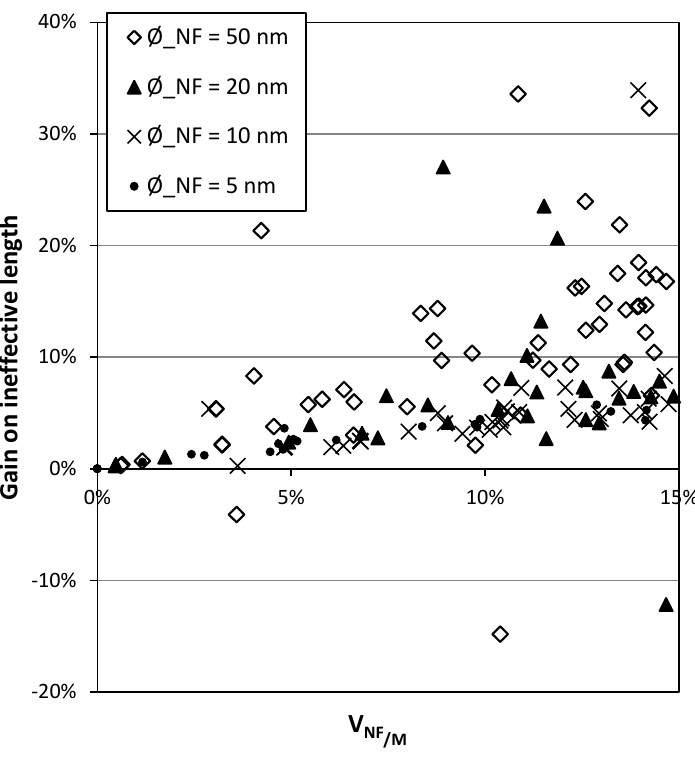
Figure 9. Gain on ineffective length as a function of NF volume fraction, for different NF diameters, with effective modeling of NF network reinforcing